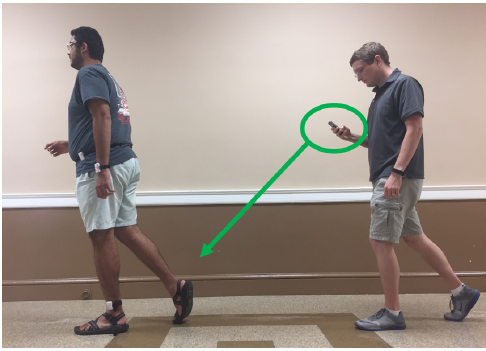
Figure 2. The procedure used in order to record all steps taken by a participant through each